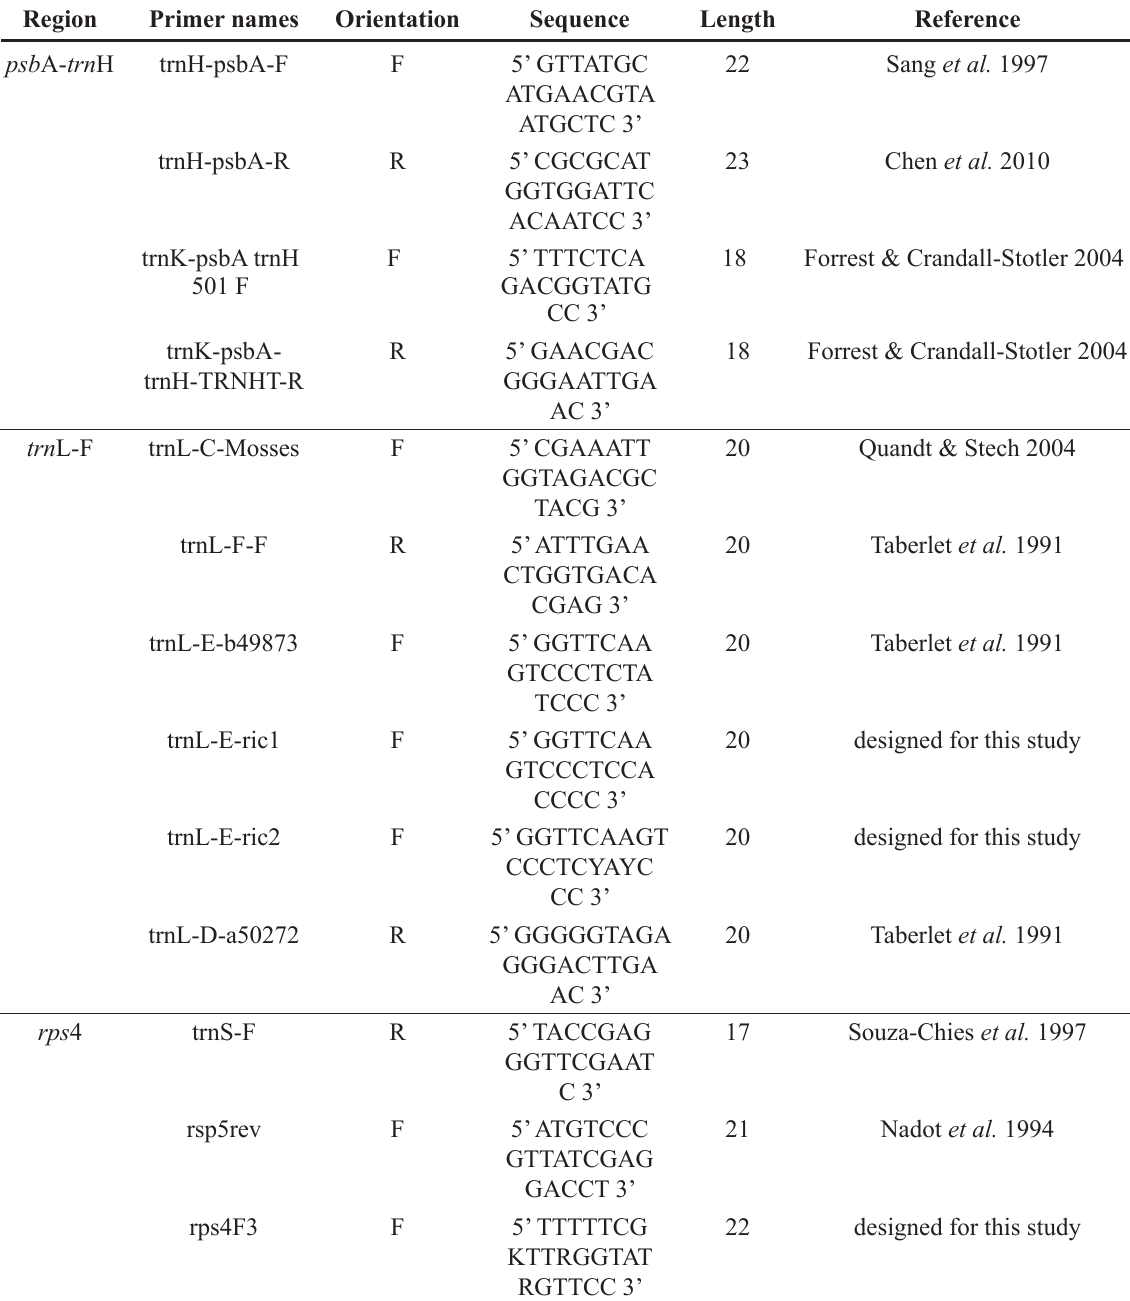
Table 1. List of different primers used for amplification of the three markers.